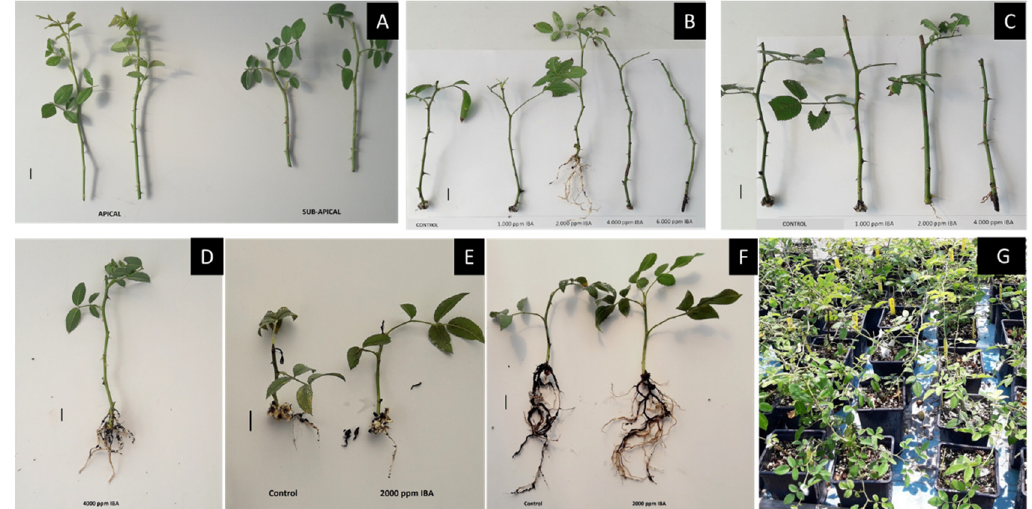
Figure 2. Representative photos of cutting propagation results (experiments in 2019 and 2020) on selected Greek native genotypes of Rosa canina originating form wild-growing material. ( A ) Softwood leafy cuttings (apical and sub-apical) of the prioritized genotype GR-1-BBGK-19,191; ( B , C ) Rooting results of apical and subapical cuttings of GR-1-BBGK-19,191, respectively, in 3:1 substrate across different hormone treatments tested; ( D ) Rooted cutting of the 4000 ppm IBA treatment in the 2020 experiment with the prioritized genotype GR-1-BBGK-03,2229; ( E , F ) Rooted cuttings of the 2020 experiment of the genotype GR-1-BBGK-19,674 (control and 2000 ppm IBA treatments) coming from mother plants with no fertilization ( E ) contrasted to those coming from mother plants with conventional fertilization in ( F ); ( G ) New plants of the genotype GR-1-BBGK-19,191 raised ex-situ under outdoor adaptation. Bars in photos A to F represent 1